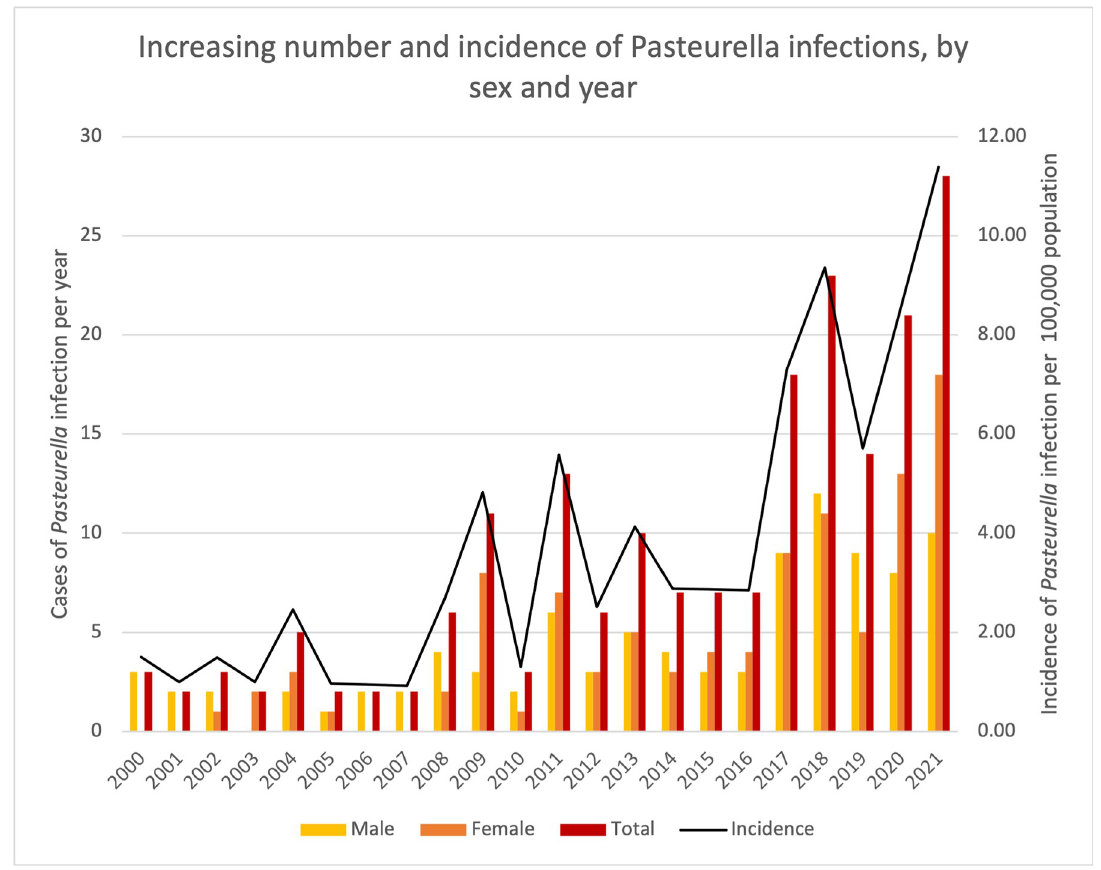
Fig 2. Increasing clinical episodes and incidence of Pasteurella spp. infections,